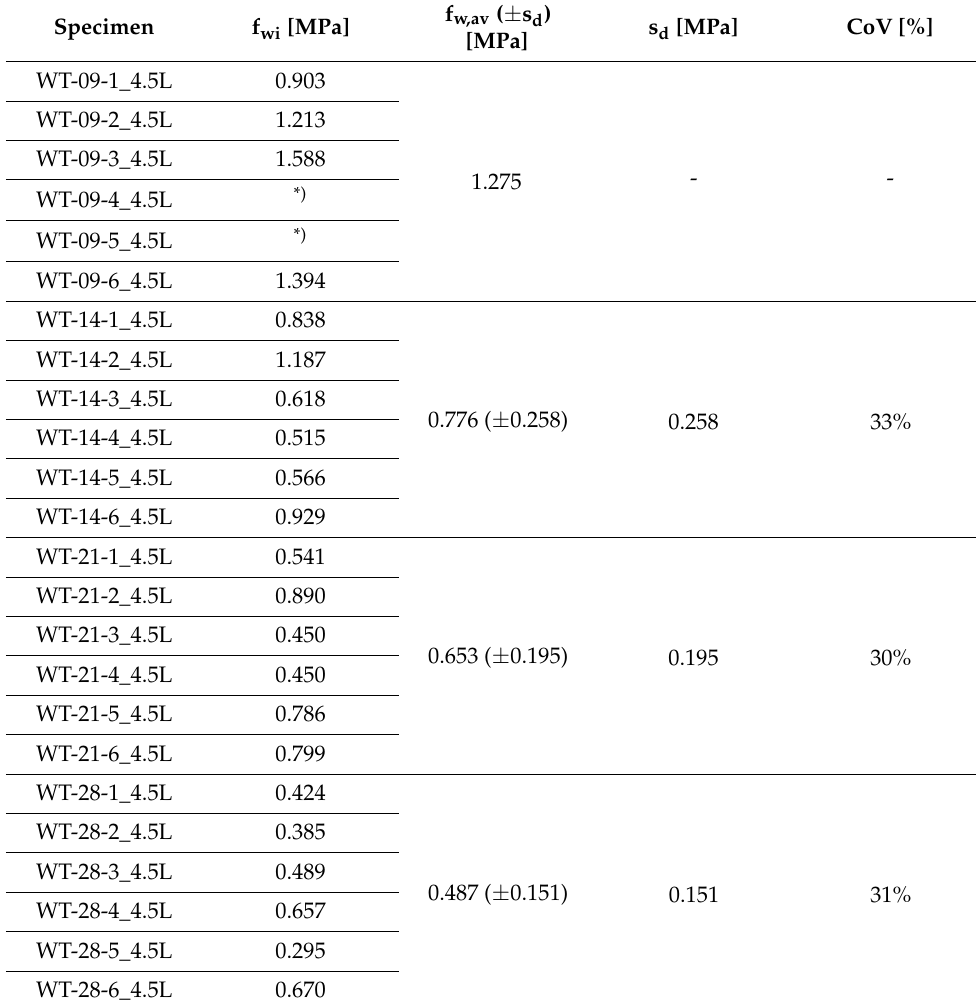
Table 5. Bond strength results for series using 4.5 L of mixing water.